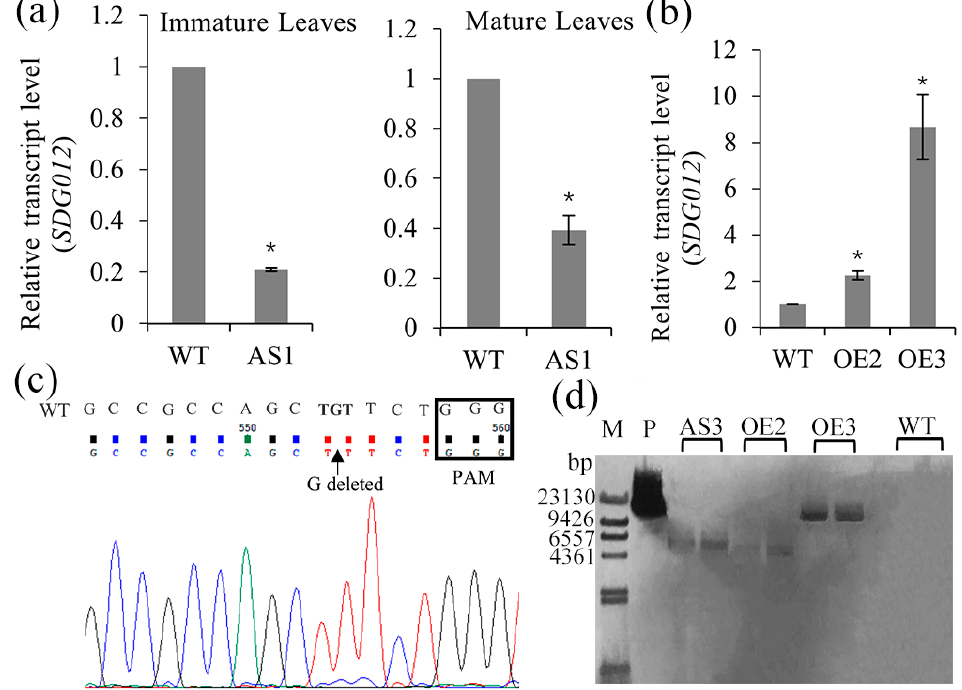
Figure 1. The downregulation and upregulation of SDG102 expression in transgenic maize plants. ( a , b ) Relative transcript level of SDG102 in the wild-type (WT), SDG102-RNAi line (AS1; ( a )), and overexpression line (OE2 and OE3; ( b )). Asterisks (*) indicate statistically significant differences between the indicated genotypes and the wild type ( p < 0.001). Error bars indicate standard deviation ( n = 3). ZmACT1 was used as an internal control. ( c ) Sequencing results of CRISPR/Cas9-mediated mutations on the SDG102 target site in transgenic plants (AS3). WT represents the sequence of the wild-type. Sequence inside the rectangle is the Protospacer Adjacent Motif (PAM) sequence. ( d ) Southern blot analysis using DNA extracted from WT, AS3, OE2, and OE3 (M = molecular weight marker; p = probe bar gene).